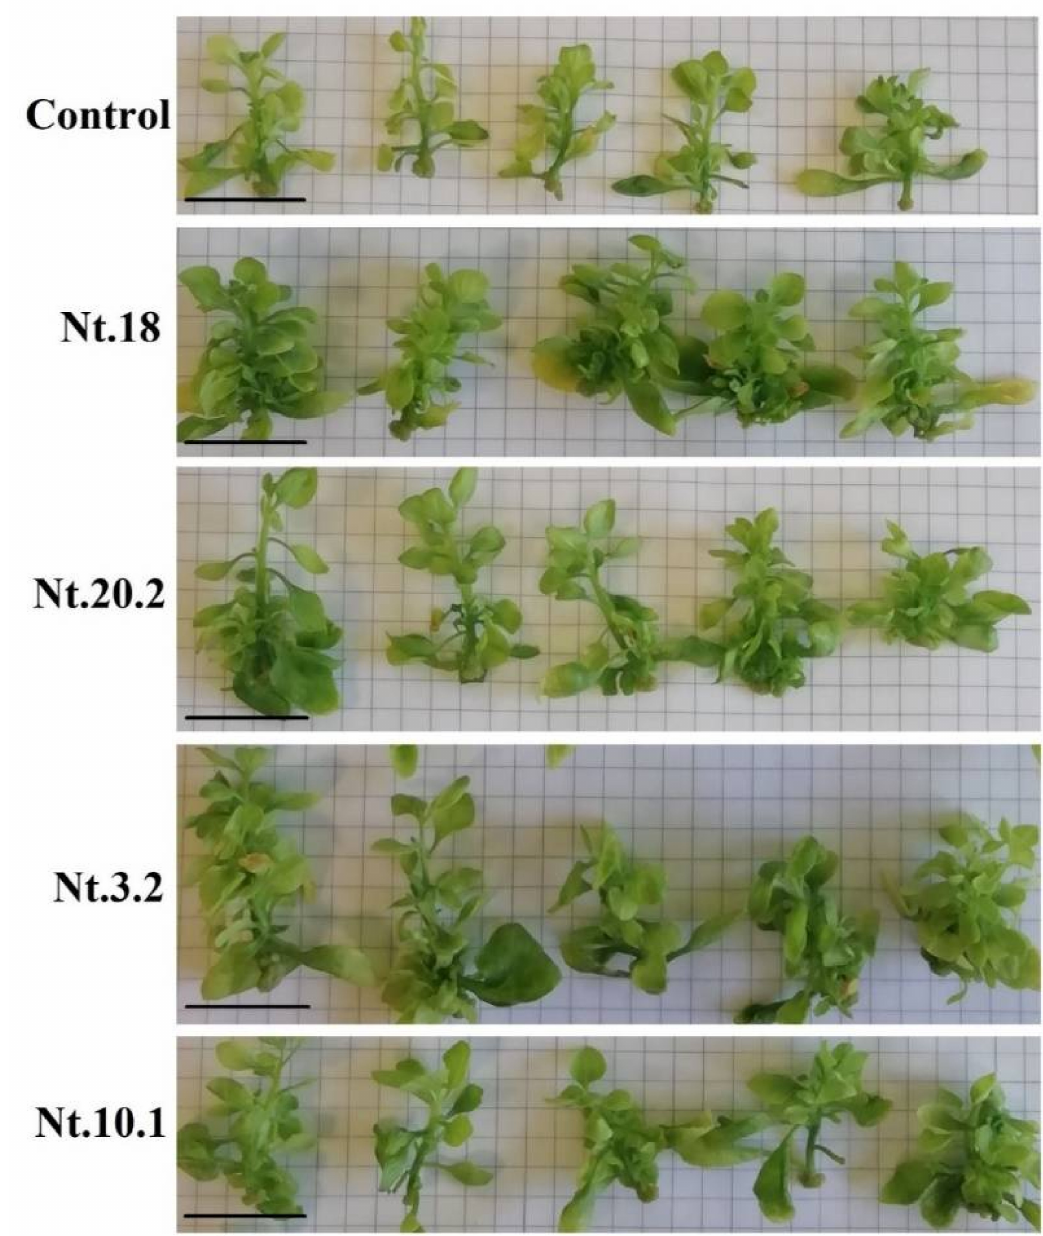
Figure A1. Tobacco ( Nicotiana tabacum L.) shoots after 3 weeks of co-cultivation with isolates Bacillus toyonensis Nt.18 and Nt.20.2, Bacillus wiedmannii Nt.3.2 and Bacillus mycoides Nt.10.1. Isolates had a significant growth-promoting effect (11% to 21% increase in shoot biomass) as compared to control shoots. Shoots were inoculated with 3 µ L of each strain suspended at ~10 7 CFU/mL in MS medium. MS medium without bacteria was used for the control treatment. Five representative shoots are shown for each experimental group. Scale bar represents 2